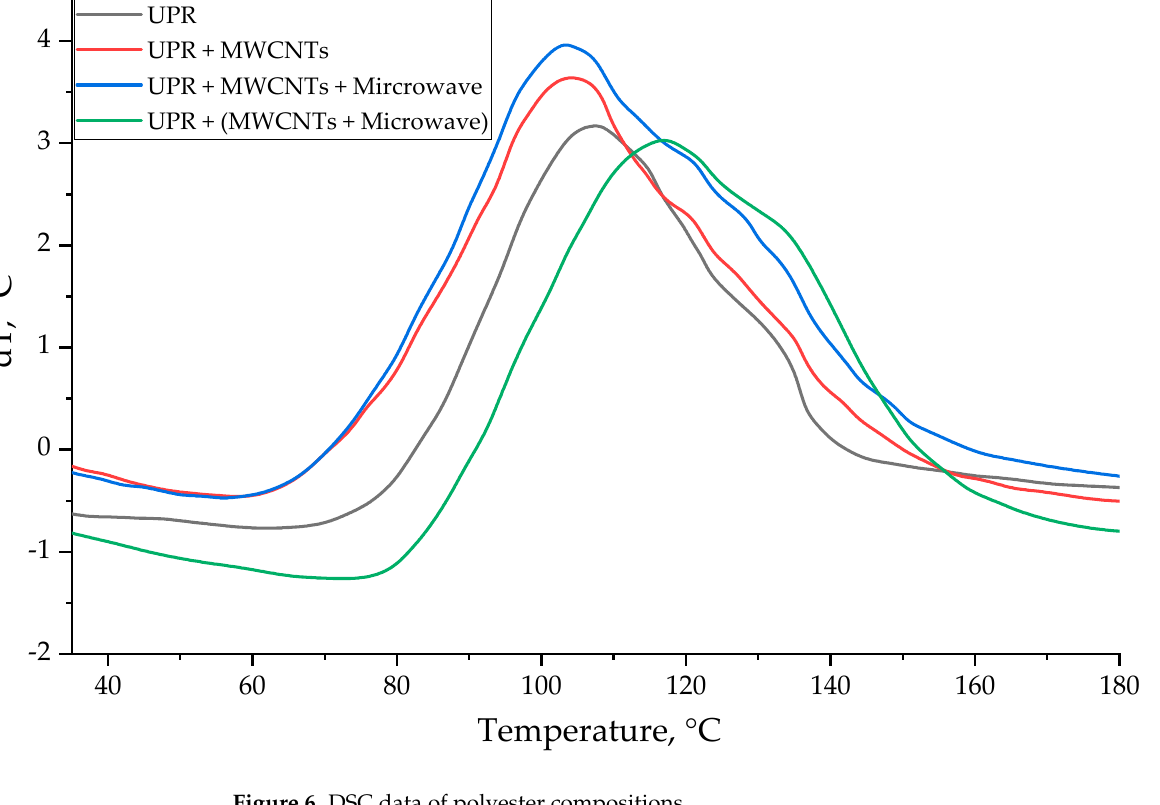
Figure 6. DSC data of polyester compositions. Table 3. Results of differential scanning calorimetry of polyester